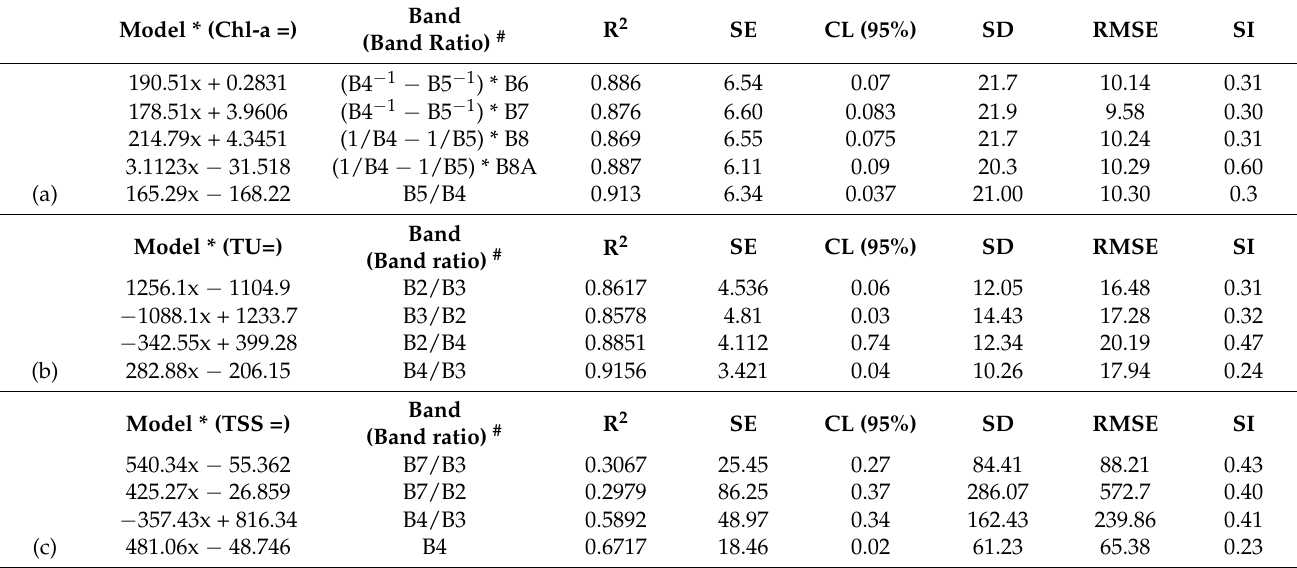
Table 3. Selected regression model for the retrieval of WQPs from Sentinel 2A MSI bands and descriptive statistics of the in situ-measured and predicted water quality parameters.